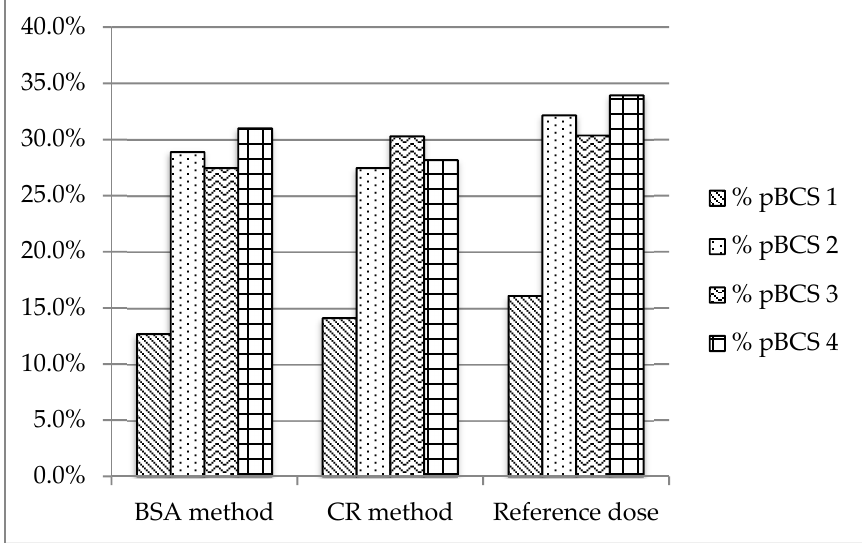
Figure 4. Distribution of provisional pBCS classification in children (2–12 years).